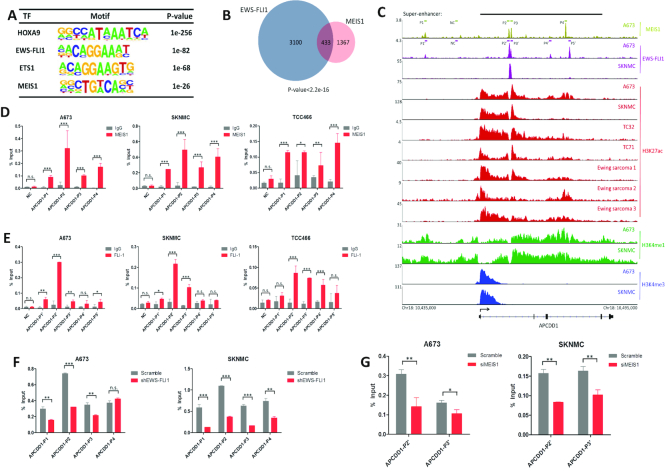
MEIS1 and EWS-FLI1 directly co-bind super-enhancer regions of APCDD1, (A) Homer Motif Enrichment results of known transcription factor binding motifs enriched at MEIS1 binding regions in A673 cells. (B) Venn diagram displaying the overlap between EWS-FLI1 and MEIS1 peaks in A673 cells. P value was calculated using Fisher's exact test. (C) Integrative Genomics Viewer showing MEIS1, EWS-FLI1, H3K27ac, H3K4me1 and H3K4me3 occupancy in APCDD1 gene in A673 and SKNMC cells as well as primary tumors. Olive and purple bars indicate template regions subjected to ChIP-qPCR experiments. (D-E) Confirmation of selected (D) MEIS1 and (E) EWS-FLI1 binding sites in APCDD1 locus by ChIP-qPCR. NC, negative control. Error bars represent mean ± SD of three replicates (n.s., statistically no significance, *P < 0.05, **P < 0.01, ***P < 0.001). (F–G) Either (F) EWS-FLI1 or (G) MEIS1 was silenced in A673 and SKNMC cells, and antibodies against either (F) MEIS1 or (G) FLI-1 were used to determine the transcription fator change in occupancy at selected regions of APCDD1 by ChIP-qPCR. Error bars represent mean ± SD of three replicates (n.s., statistically no significance, *P < 0.05, **P < 0.01, ***P < 0.001).